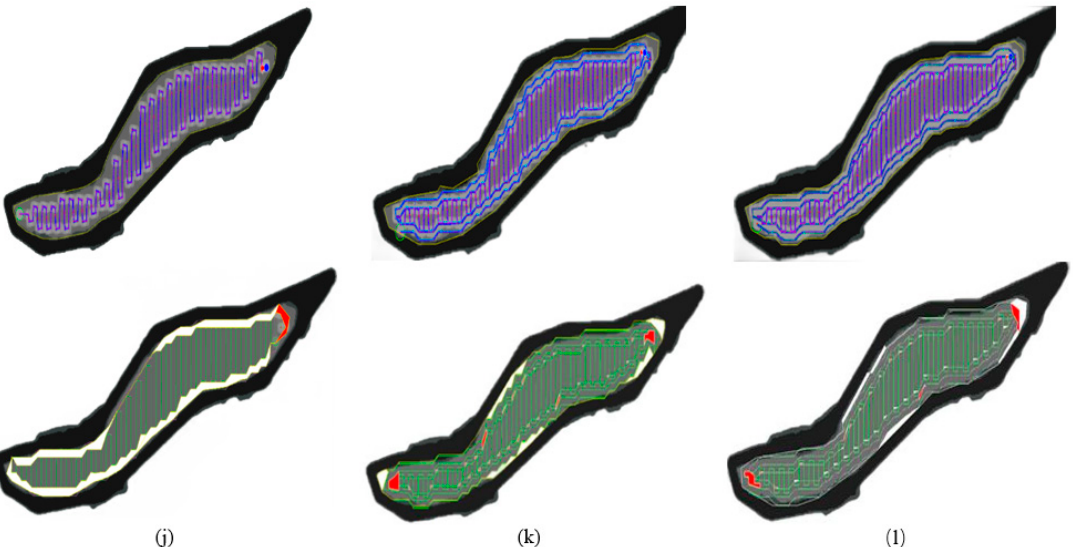
Figure 9. Screenshot of the calculation example results for irregular fields. ( a ) B-ield 1 path planning simulation and replay evaluation of the EHNS algorithm; ( b ) B-field 1 path planning simulation and replay evaluation of the BP algorithm; ( c ) B-field 1 path planning simulation and replay evaluation of the IFC algorithm; ( d ) B-field 2 path planning simulation and replay evaluation of the EHNS algorithm; ( e ) B-field 2 path planning simulation and replay evaluation of the BP algorithm; ( f ) B-field 2 path planning simulation and replay evaluation of the IFC algorithm; ( g ) A-field 3 path planning simulation and replay evaluation of the EHNS algorithm; ( h ) A-field 3 path planning simulation and replay evaluation of the BP algorithm; ( i ) A-field 3 path planning simulation and replay evaluation of the IFC algorithm; ( j ) A-field 4 path planning simulation and replay evaluation